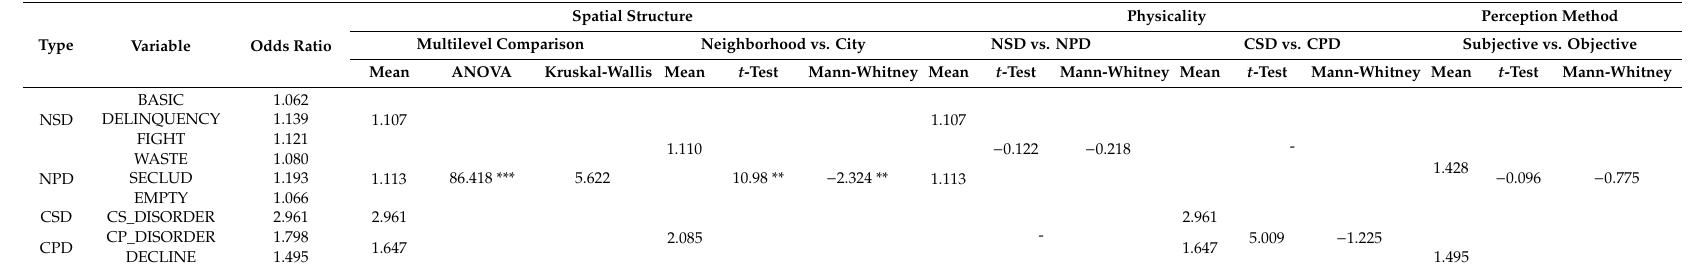
Table 8. Multilayered disorder impacts on the fear of